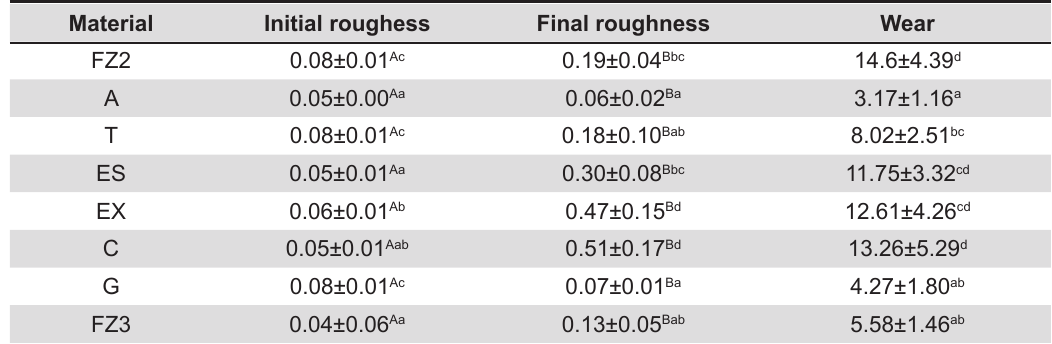
Table 1- Mean and standard deviation of initial surface roughness (Ra), final surface roughness (Ra) and wear after simulated toothbrushing (μm)